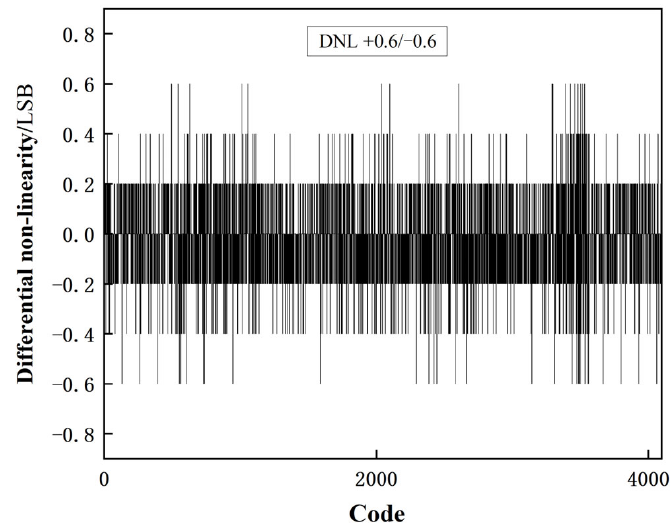
Figure 12. DNL test result.